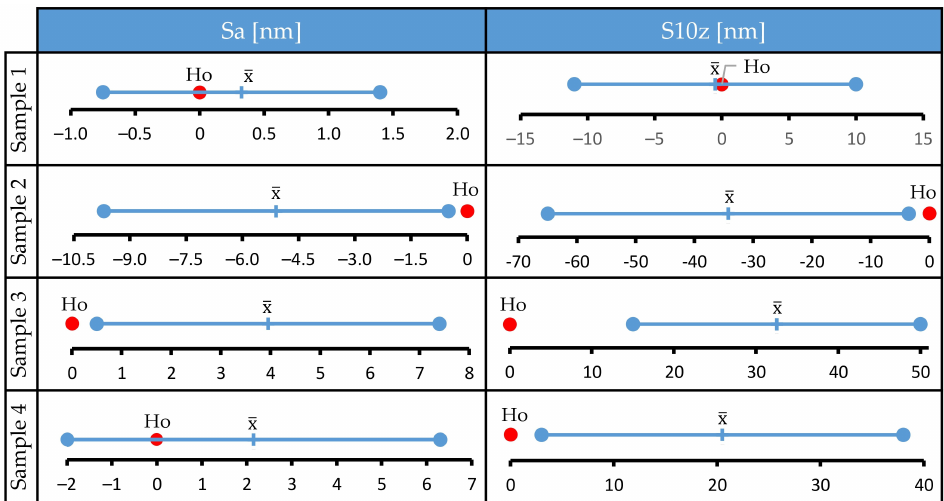
Figure 5Figure 5. Average values of Sdr and Ssk surface roughness parameters determined on areas of 10 × 10 µ m and corresponding confidence intervals (CI) of all investigated samples.